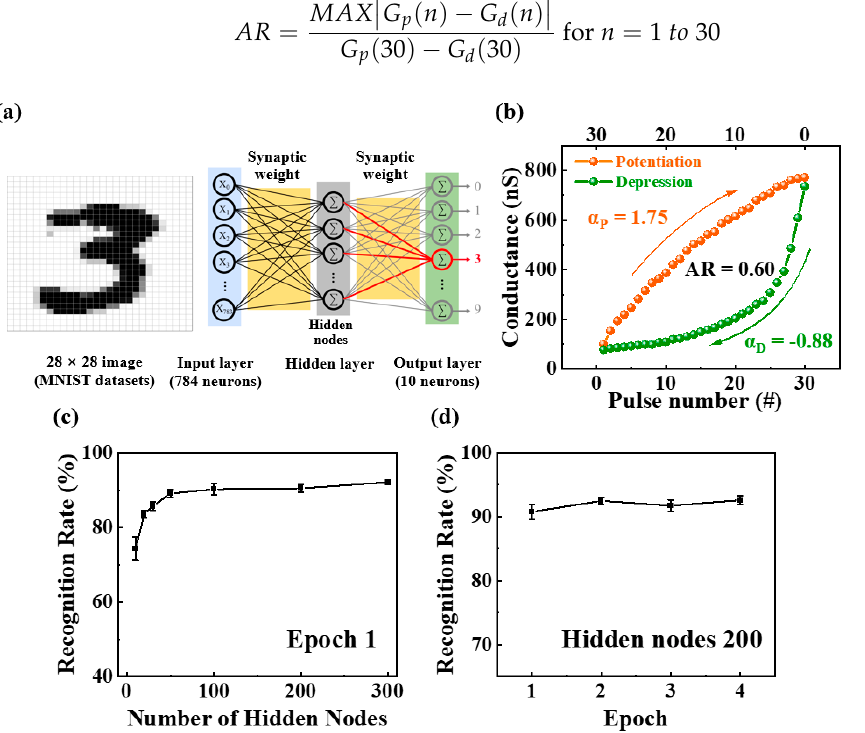
Figure 7. ( a ) Schematic of three-layer (input, hidden, and output layers) fully connected artificial neural network (ANN) for MNIST handwritten digit simulation; ( b ) nonlinearity analysis of normalized depression and potentiation (G/G max ); recognition rate based on ( c ) number of hidden nodes in epoch 1 and ( d ) number of epochs with 200 hidden nodes.